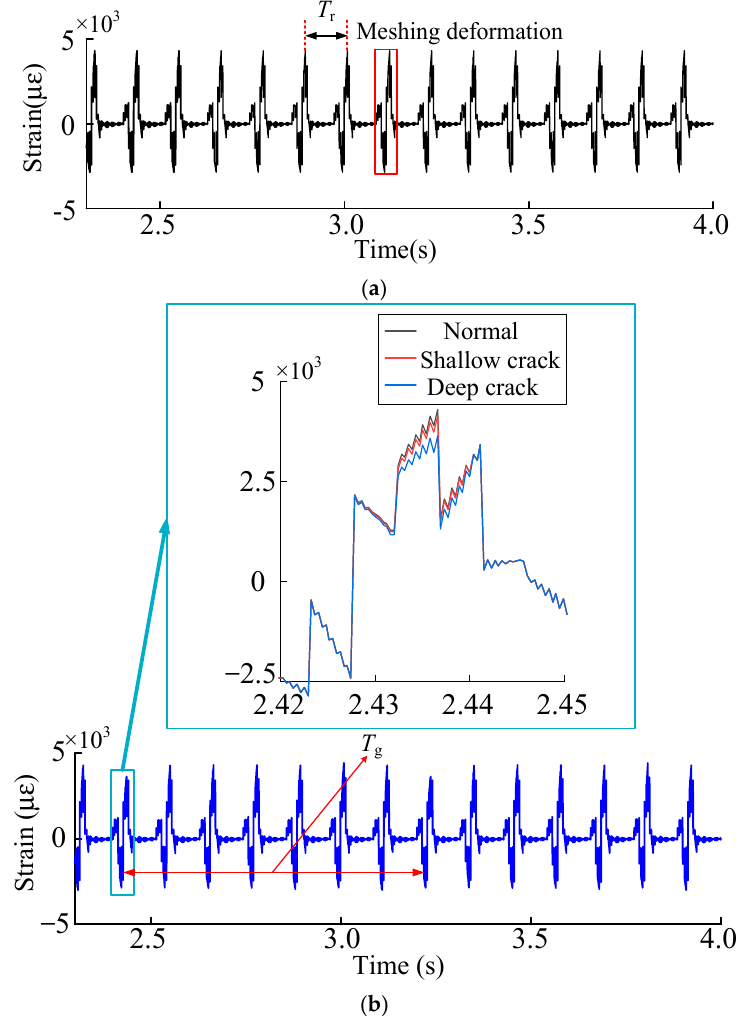
Figure 14. ( a ) Time domain history of the gear ring root strain under normal working conditions. ( b ) Time domain history of tooth root strain of sun gear under crack condition.